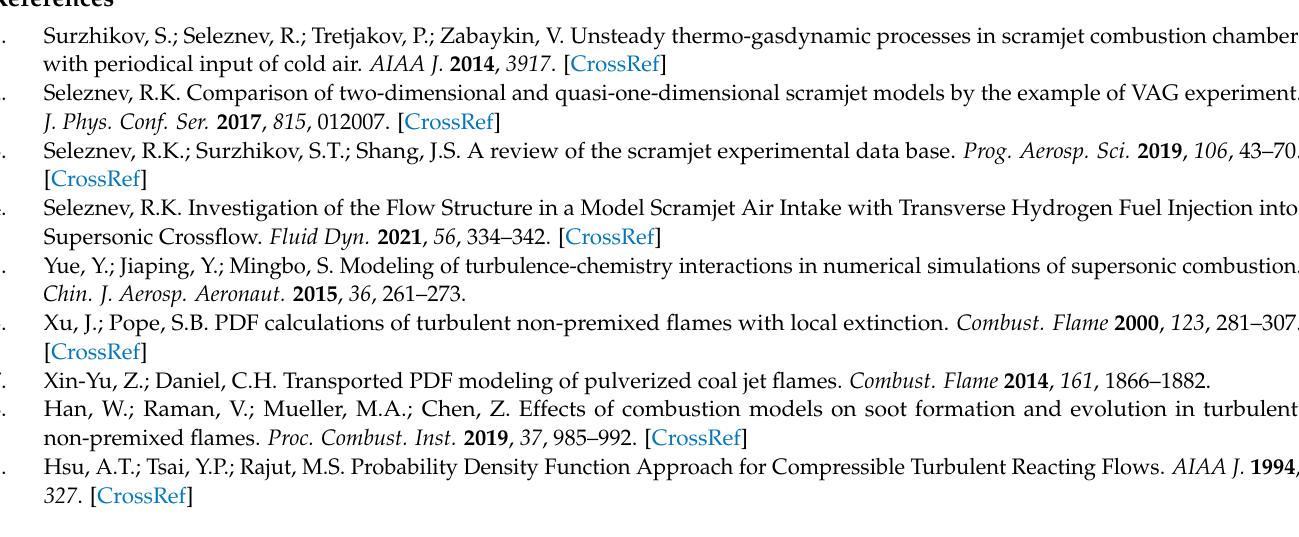
Figure A2. Cross-stream profiles of Reynolds-averaged values of the OH mass fraction under different C φ : mass fraction calculated by FMDF-IEM for M c = 0.4 case, mass fraction calculated by FMDF-EMST for M c = 0.4 case, mass fraction calculated by FMDF-IEM for M c = 0.8 case, mass fraction calculated by FMDF-IEM for M c = 0.8 case.